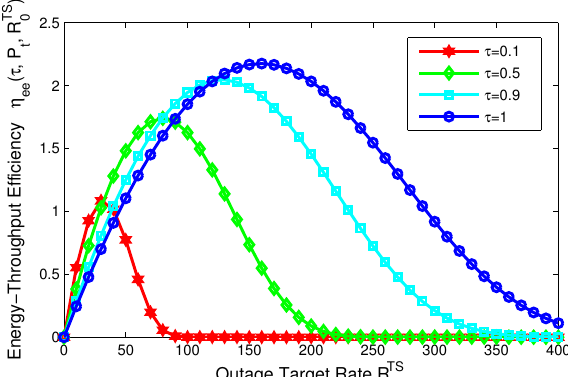
Figure 19. Energy-throughput efficiency versus outage target rate with different time switching slot for TS